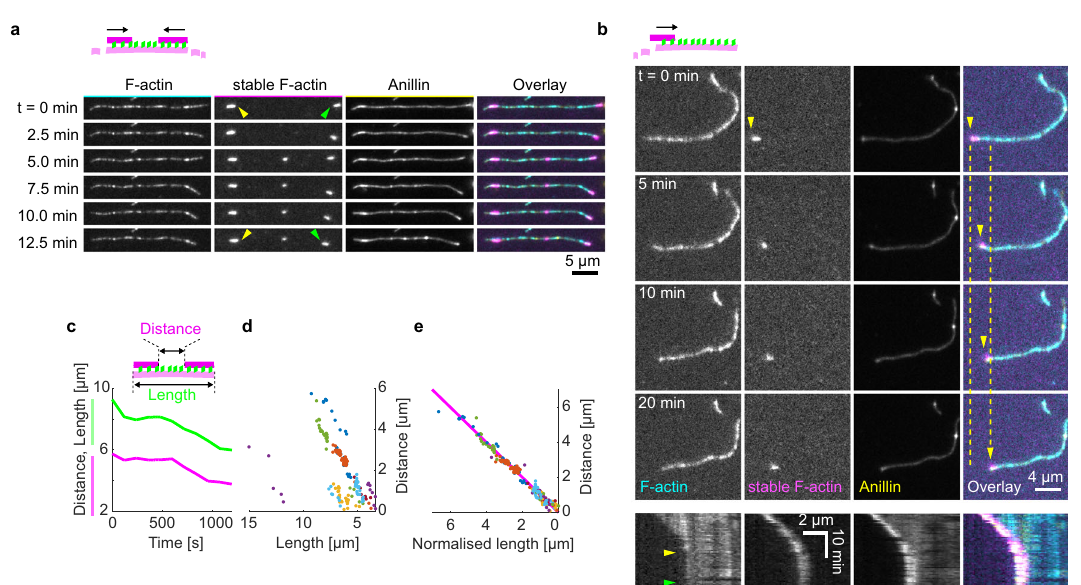
Fig. 3 Anillin couples with actin disassembly to generate directed fi lament sliding. a Fluorescence time-lapse micrographs showing two short phalloidin- stabilised actin fi laments sliding along with the retreating ends of a non-stabilised disassembling actin fi lament (see Movie 6). Arrowheads indicate the inner ends of the two stabilised actin fi laments coming closer to each other. b Fluorescence time-lapse micrographs showing one short phalloidin-stabilised actin fi lament sliding along with the retreating end of a non-stabilised disassembling actin fi lament. Below, multicolour fl uorescence kymograph of the event, showing that transient pauses in the disassembly (beginning and end of the pause indicated by yellow and green arrowheads) result in transient pauses in the fi lament sliding (see Movie 7). c Typical time-traces of the length of the non-stabilised actin fi lament (green) and the distance between the two short stabilised fi laments (magenta) moving with the ends of the non-stabilised actin fi lament. d , e The distance between the stabilised actin fi laments decreases linearly with the length of the disassembling actin fi lament ( n = 12 events in nine experiments, colours denote individual